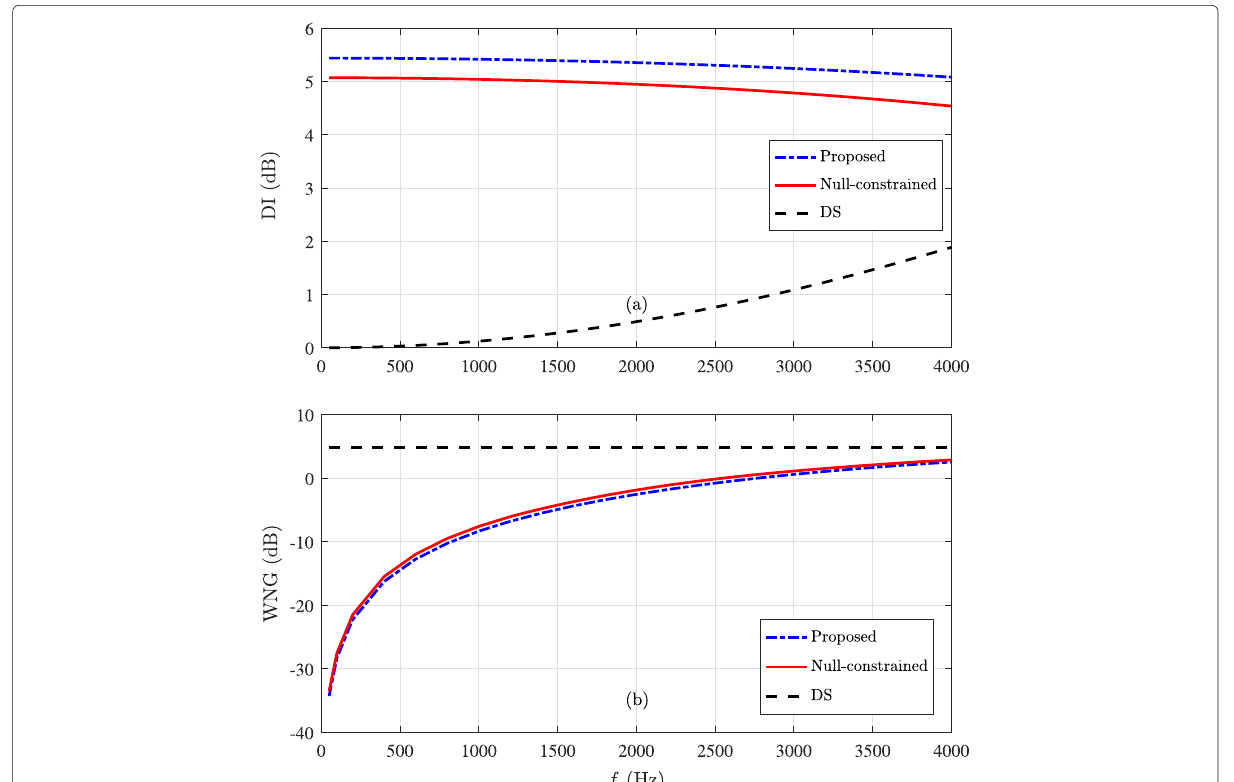
Fig. 14 DI and WNG of the proposed differential beamformer, the conventional null-constrained differential beamformer in [37], and the DS beamformer: a DI and b